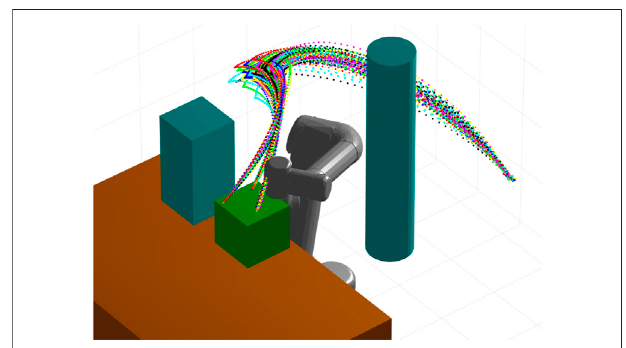
FIGURE1| AsetofrobottrajectoriesgeneratedbyourCLF/CBF-based ProMP demonstration and control method. The controller guarantees that the systemneverleavesaneighborhoodde fi nedbythetrainingsetandprovidesa straightforward way to de fi ne trajectories that enforce safety constraints in the presence of obstacles. Copyright 2021 IEEE. Reprinted, with permission, from Davoodi et al.,